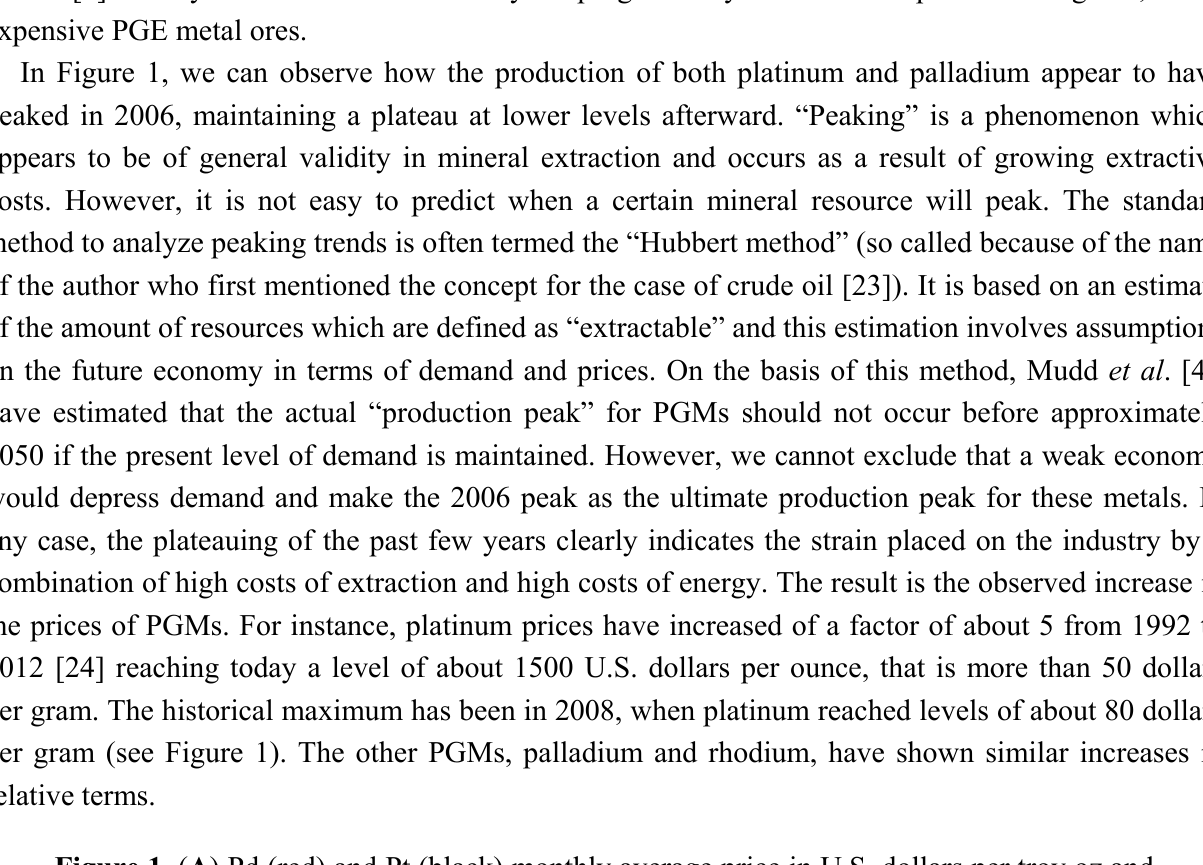
Figure 1. ( A ) Pd (red) and Pt (black) monthly average price in U.S. dollars per troy oz and ( B ) world production in thousands of tons. Data sources